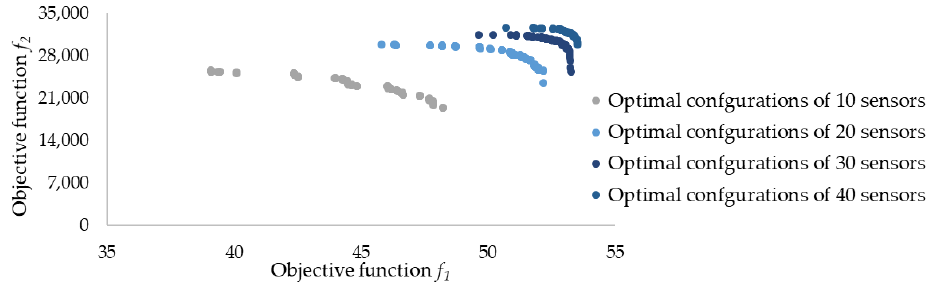
Figure 6. Example of obtained Pareto fronts for 10, 20, 30 and 40 sensors.